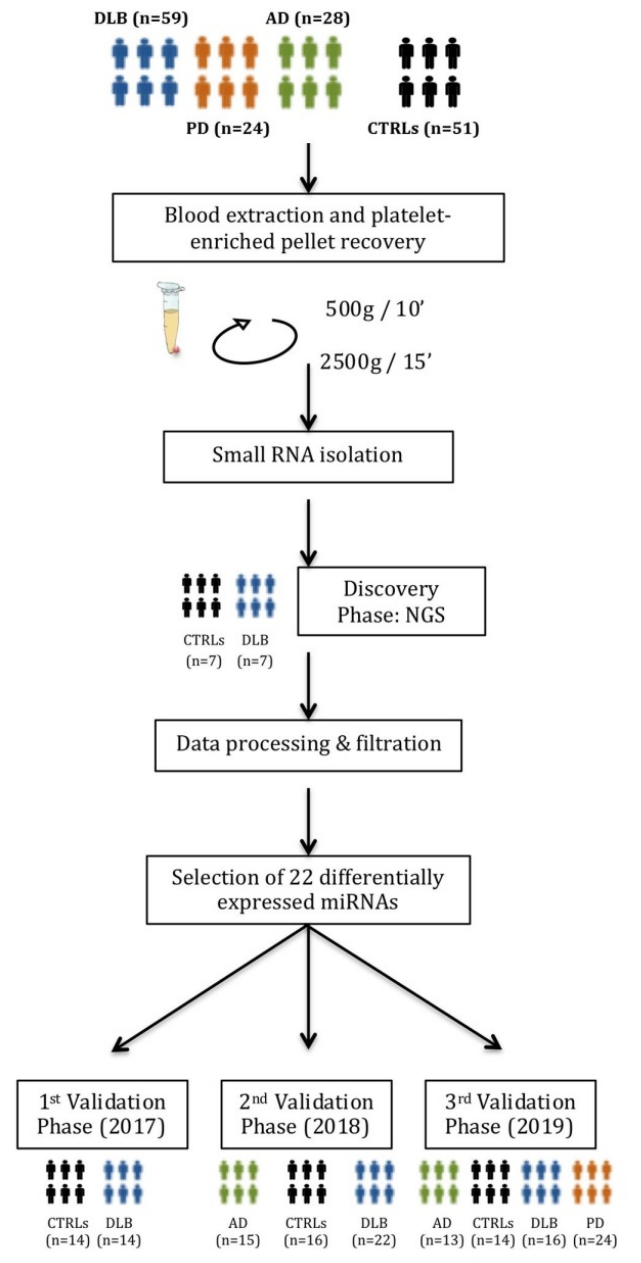
Figure 1. The complete workflow of the current study. A first discovery phase by Next-Generation Sequencing (NGS) included a cohort of 7 DLB patients and 7 healthy controls. Selected miRNAs were validated in three independent qPCR validation studies.